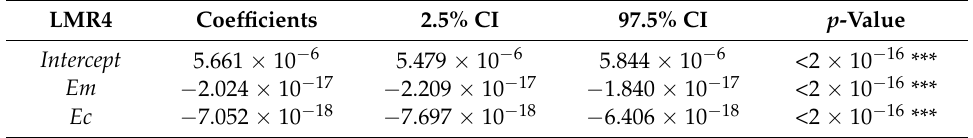
Table 10. Regression statistic: case 3.2.2—Thicker